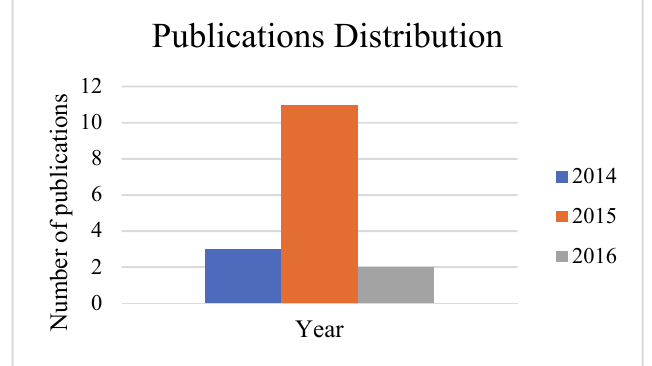
Fig. 3. Grouping by year of